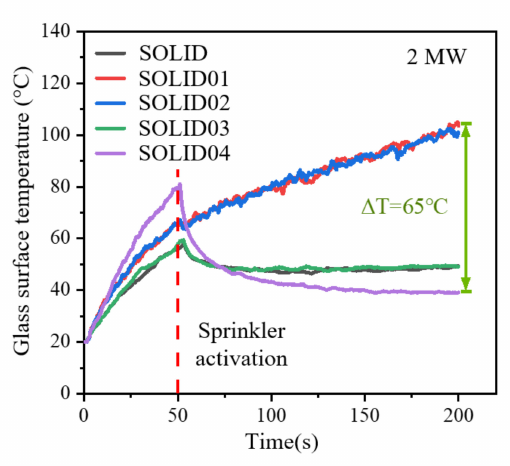
Figure 11. Glass surface temperature change under window sprinkler